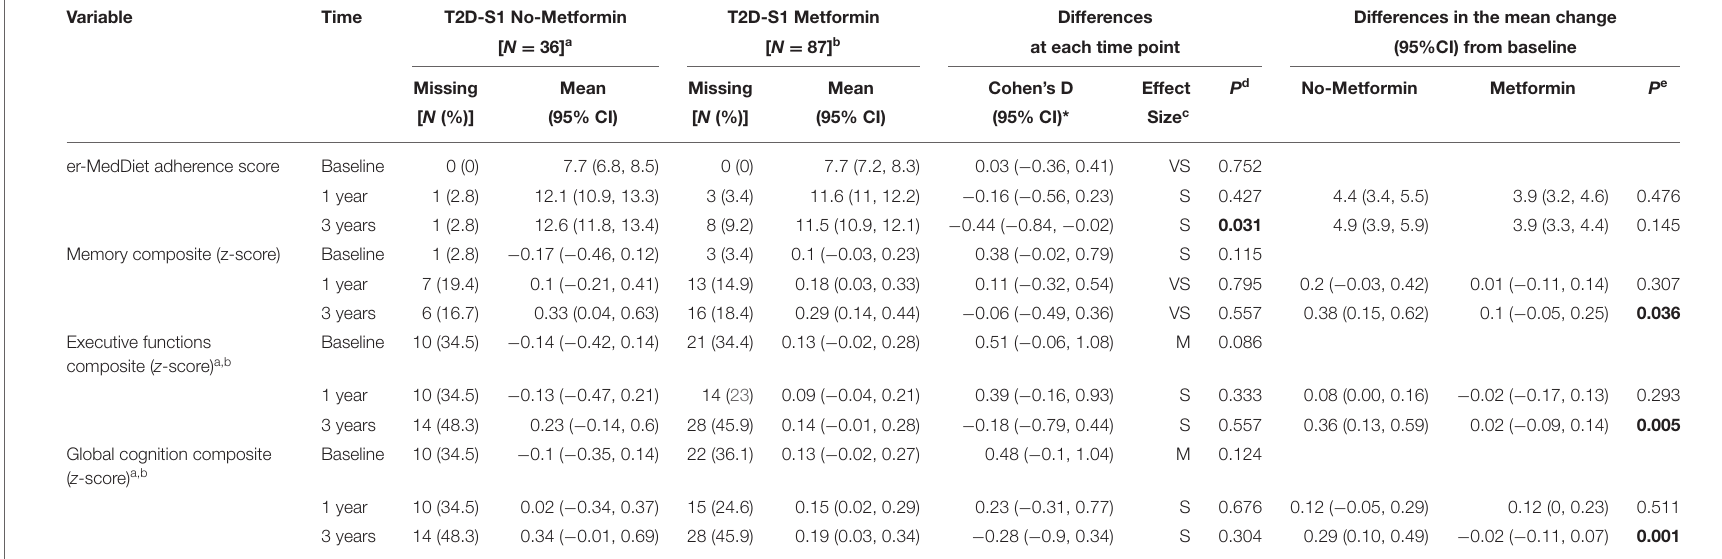
TABLE 2 | Differences in MedDiet adherence and in cognitive composites at each time point and in the mean change from baseline between individuals with type 2 diabetes from subgroup 1 (T2D-S1) treated with metformin and not treated with metformin (matched with inverse probability of treatment weights).